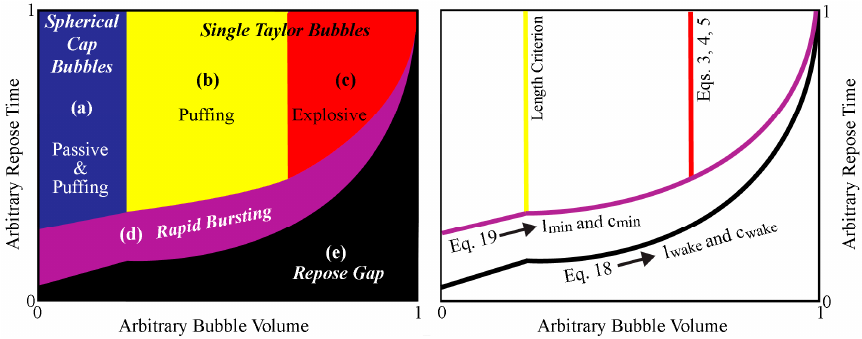
Figure 2. Left—an illustrative example of the zonation between activity classes associated with the model, plotted on arbitrary inter-bubble repose time vs. bubble volume axes. Within area ( a ) are spherical-cap bubbles, which produce passive activity or light puffing, ( b , c ) are Taylor bubble flow scenarios resulting in non-explosive and explosively-bursting scenarios, respectively. Area ( d ) represents cases where bubbles rise in sufficient proximity to one another to affect one another’s fluid dynamics, while ( e ) corresponds to a region in which independent bubble bursting is unlikely due to coalescence between neighboring bubbles. Right—a further illustrative example with only defining lines between sections of the model. Important equations and bubble features are highlighted. Please see the text for full details on these.